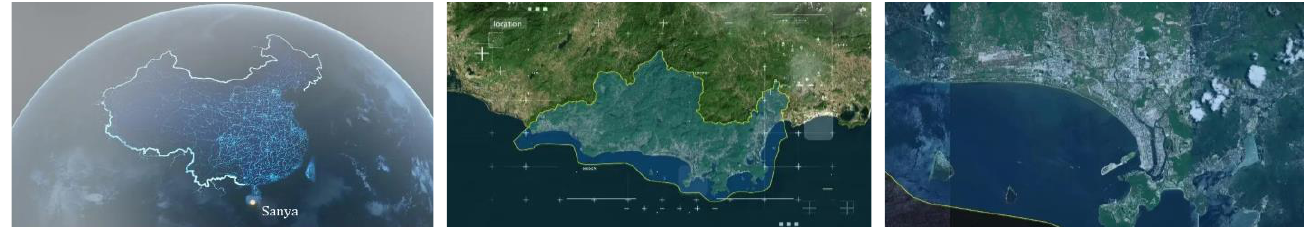
Figure 3. Map of Sanya.